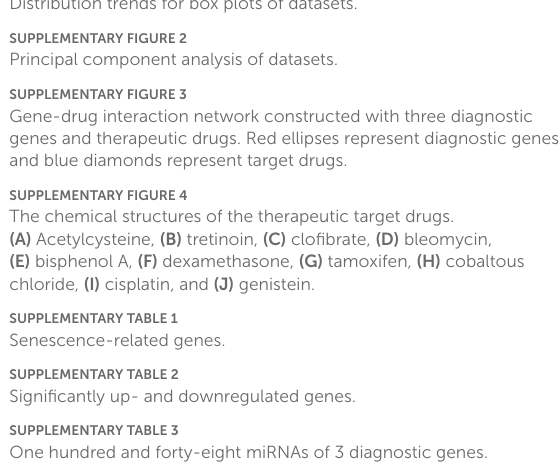
SUPPLEMENTARYFIGURE1 Distribution trends for box plots of datasets. SUPPLEMENTARYFIGURE2 Principal component analysis of datasets. SUPPLEMENTARYFIGURE3 Gene-drug interaction network constructed with three diagnostic genes and therapeutic drugs. Red ellipses represent diagnostic genes, and blue diamonds represent target drugs. SUPPLEMENTARYFIGURE4 The chemical structures of the therapeutic target drugs. (A) Acetylcysteine, (B) tretinoin, (C) clofibrate, (D) bleomycin, (E) bisphenol A, (F) dexamethasone, (G) tamoxifen, (H) cobaltous chloride, (I) cisplatin, and (J) genistein. SUPPLEMENTARYTABLE1 Senescence-related